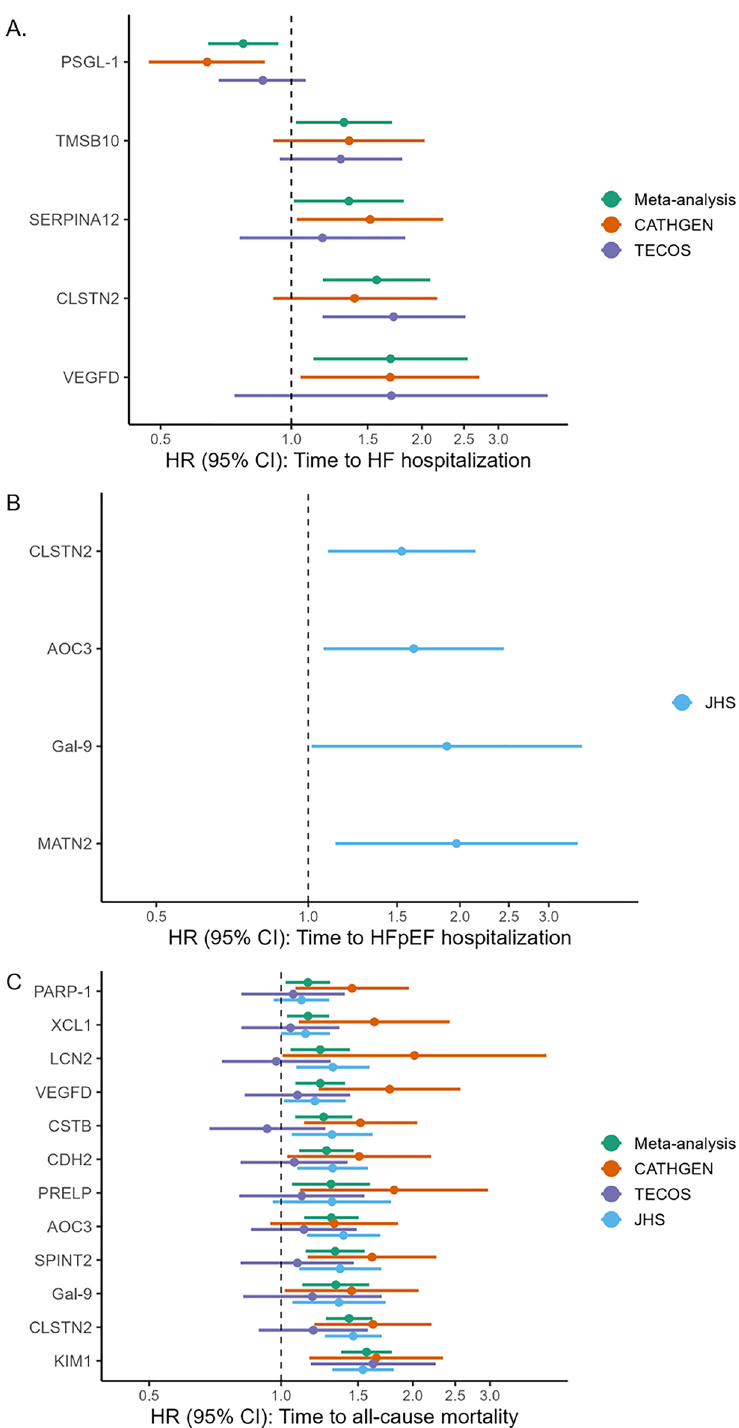
Figure 4. HFpEF-proteins associated with incident outcomes. The forest plots show the HR and 95% CI for the significant proteins associated with ( A ) incident HF hospitalization in CATHGEN and TECOs; ( B ) incident HFpEF hospitalization in JHS; ( C ) all-cause mortality in CATHGEN, TECOS and